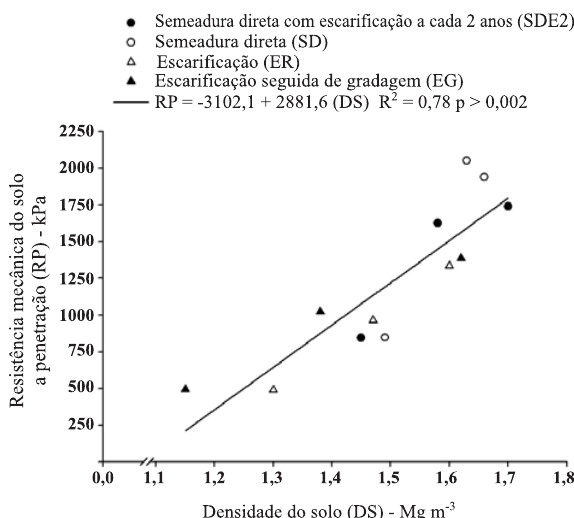
gradagem.Figura 2. Relação entre resistência mecânica do solo à penetração (RP) e a densidade do solo